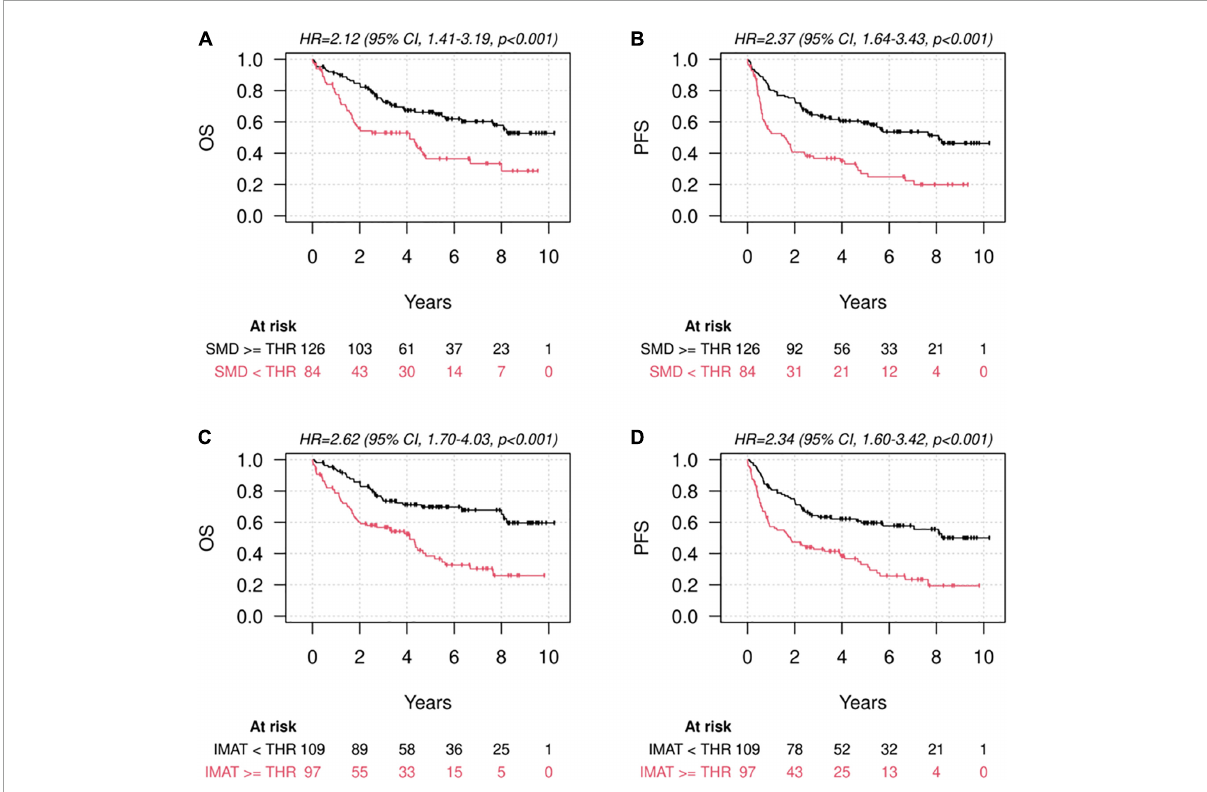
FIGURE3 Survival according to muscle quantity and quality. Kaplan-Meier diagrams for Overall Survival (OS) (A,C) and Progression-Free Survival (PFS) (B,D) , subdivided by higher-and lower-than-thresholds skeletal muscle density at the level of L3 (L3-SMD) according to the cut-offs defined by Martin et al. (11) (A,B) and higher-and lower-than-thresholds intermuscular adipose tissue area at the level of L3 (L3-IMAT), according to the cut-offs defined by means of cut-point analysis on our population (C,D)